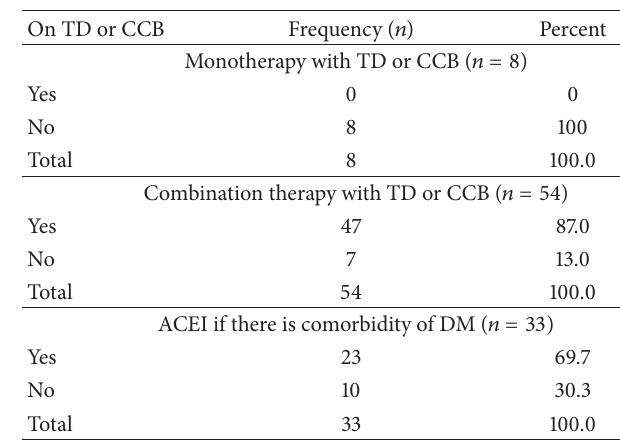
Table 3: Medication regimen.